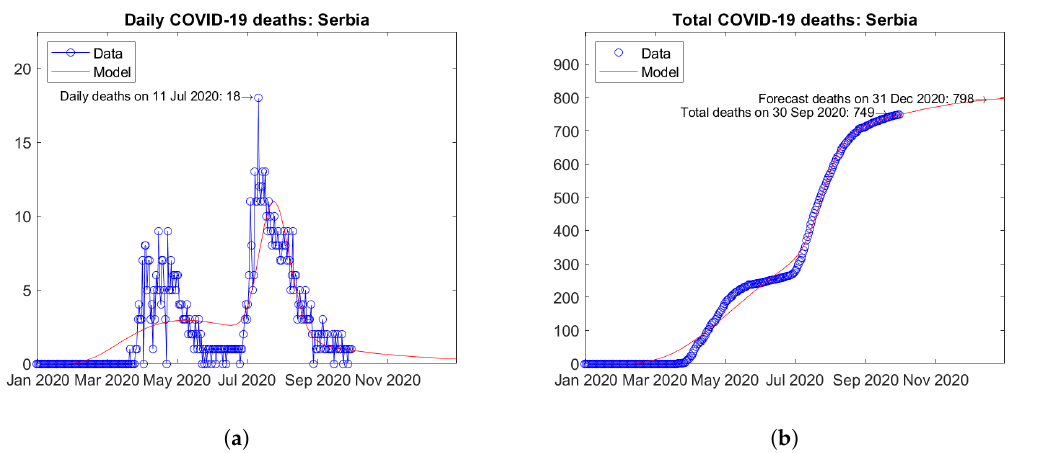
Figure 13. Actual and predicted trends in Serbia: ( a ) daily deaths, ( b ) total